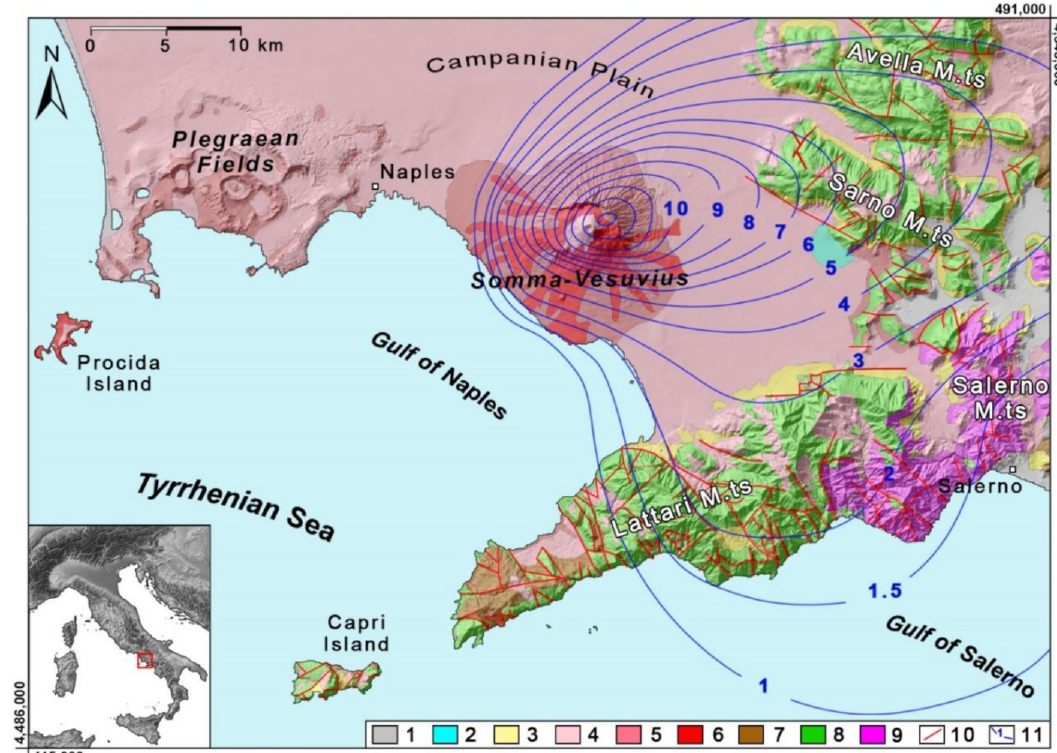
Figure 1. Geological setting of the peri–Vesuvian area: (1) alluvial deposits; (2) travertine deposits; (3) debris and slope talus deposits; (4) incoherent ash-fall deposits (Recent Pyroclastic Complex); (5) mainly coherent ash-fall deposits (Ancient Pyroclastic Complex); (6) lavas; (7) Miocene flysch; (8) Middle Jurassic–Upper Cretaceous limestones; (9) Lower Triassic– Middle Jurassic dolomites and calcareous limestones; (10) outcropping and buried faults; (11) total isopachs line (in m) of ash- fall pyroclastic deposits erupted by the Plinian Somma–Vesuvius’ eruptions (WGS84/UTM 33N) (modified from